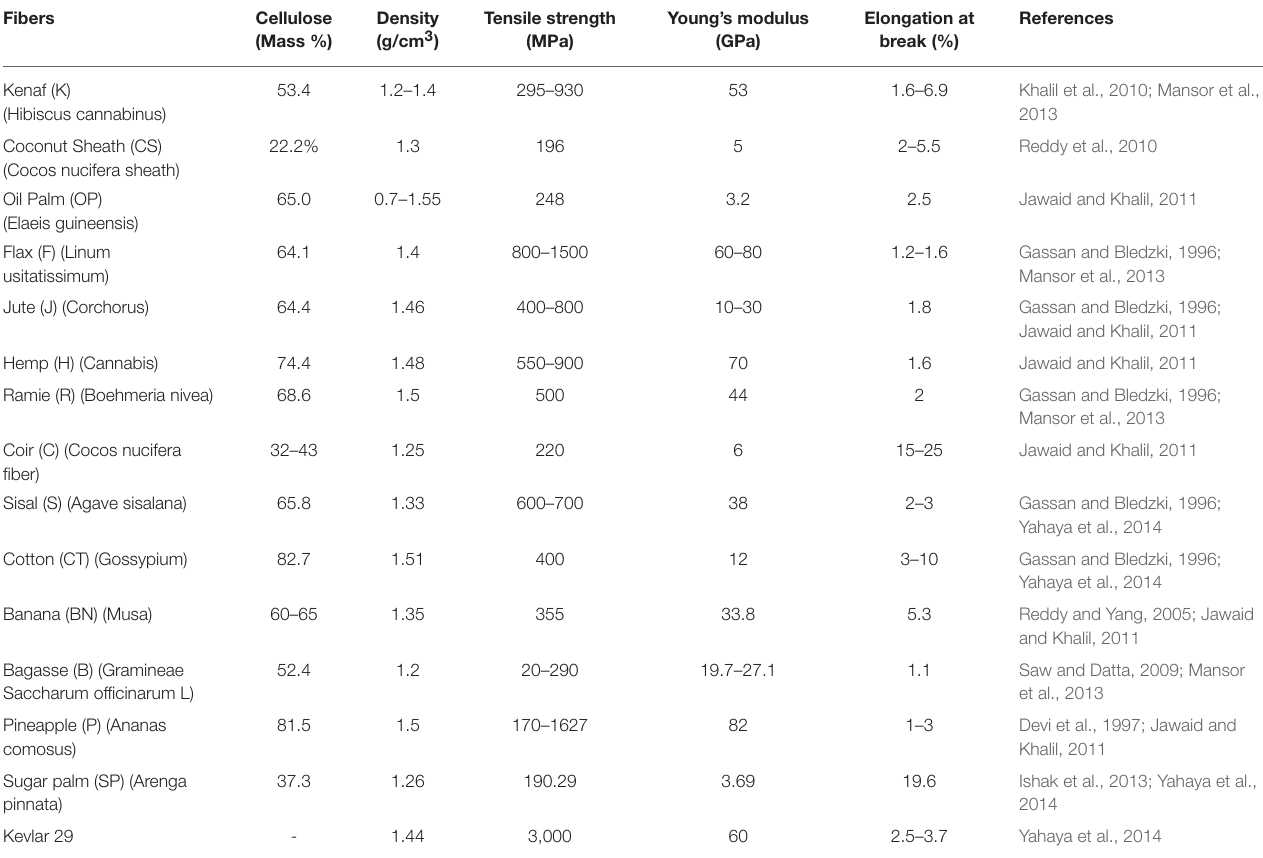
TABLE 4 | Cellulose and mechanical properties of alternate natural fibers and Kevlar